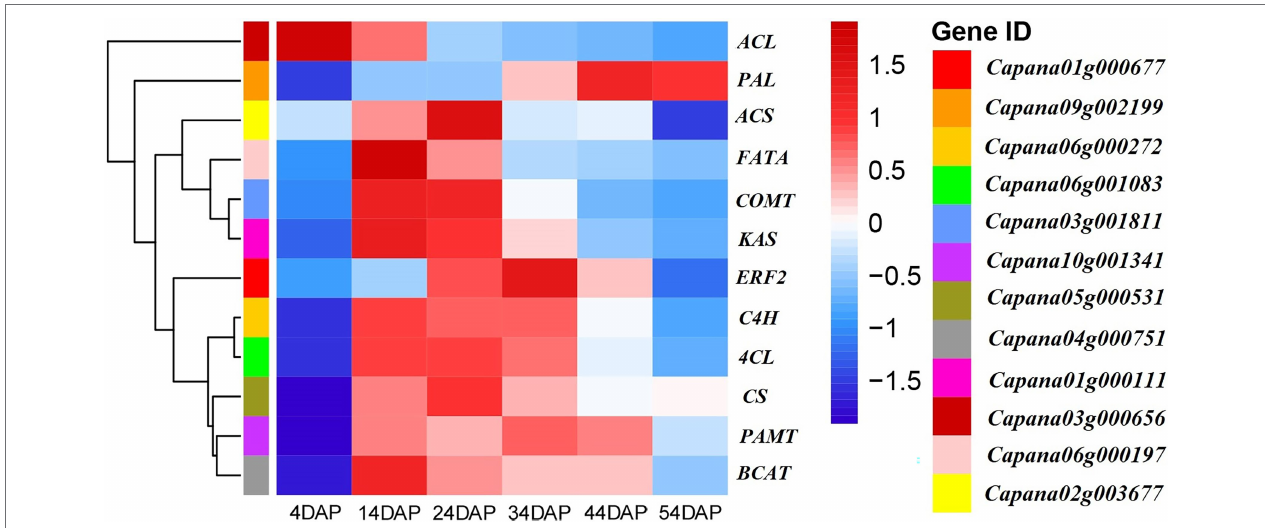
FIGURE 1 | Heat map indicating the capsaicinoids (CAPs) biosynthesis genes (CBGs) and CcERF2 expression patterns in fruit of inbred line SL08. The heatmap was generated by transcriptome sequencing data with R software packages. The data were normalized in each row, and the numbers on the right side of the figure indicate the gene expression level corresponding to